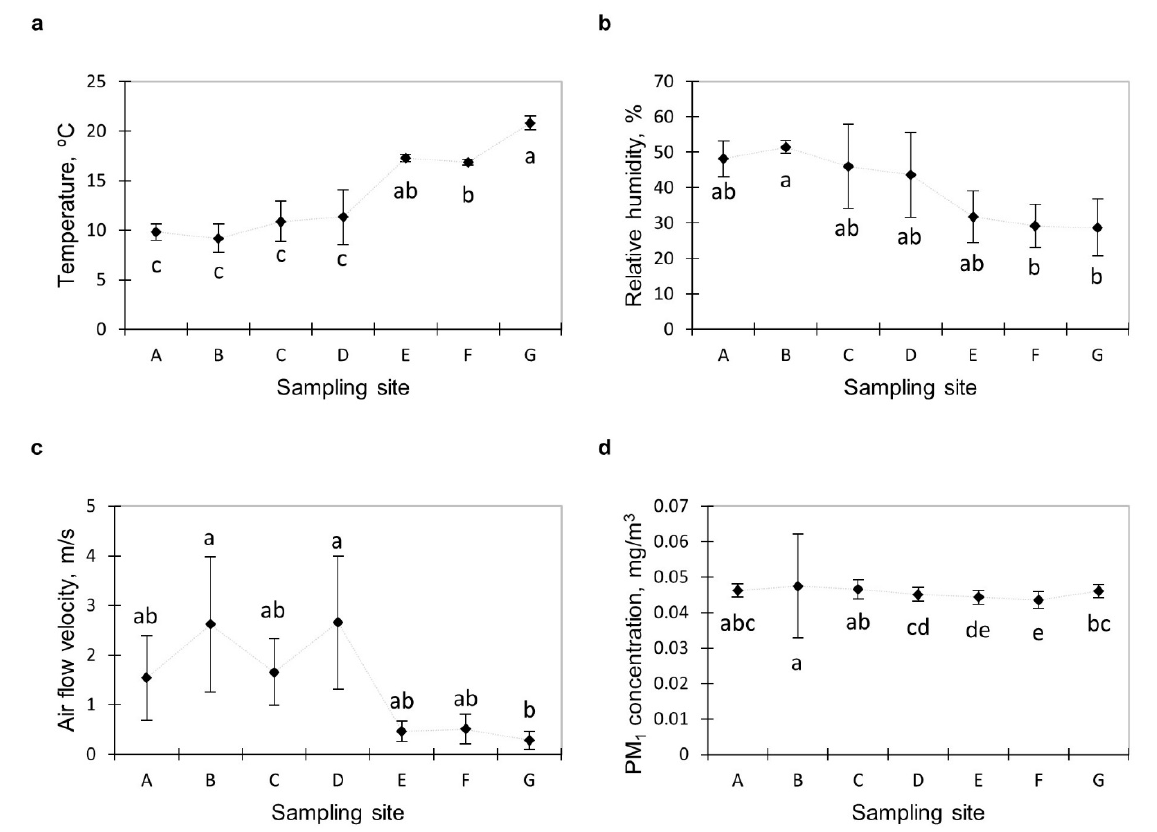
Figure 3. Microclimate and airborne dust concentration parameters in tested landfill site; ( a ) tem- perature, ( b ) relative humidity, ( c ) air-flow velocity, ( d ) concentration of dust. Statistically different samples within the same microorganism group were marked with different letters (Tukey’s test at p = 0.05).